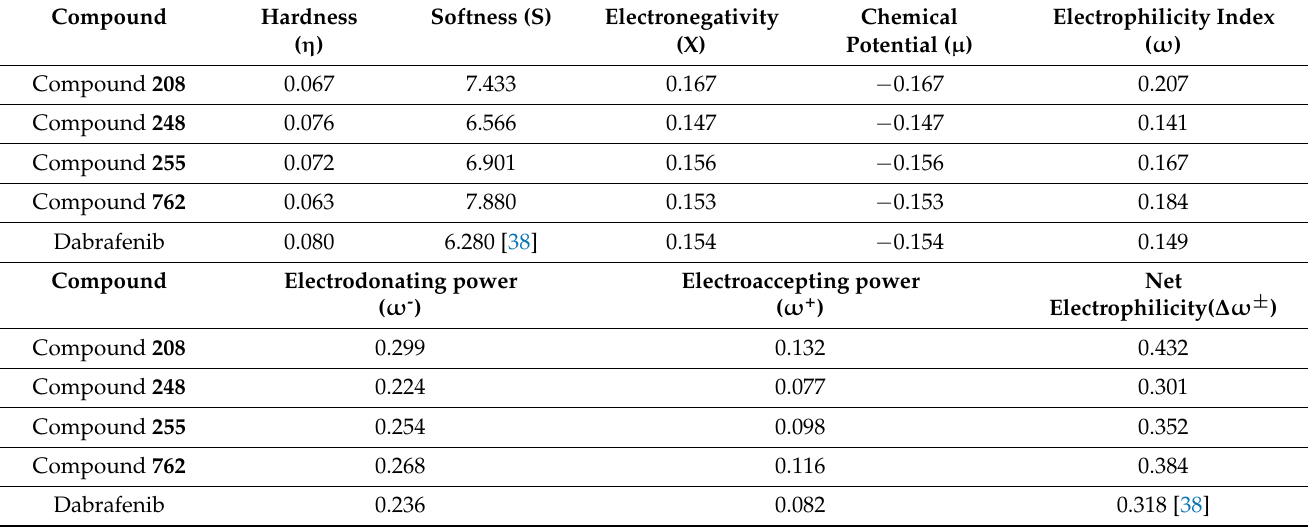
Table 3. Global reactivity